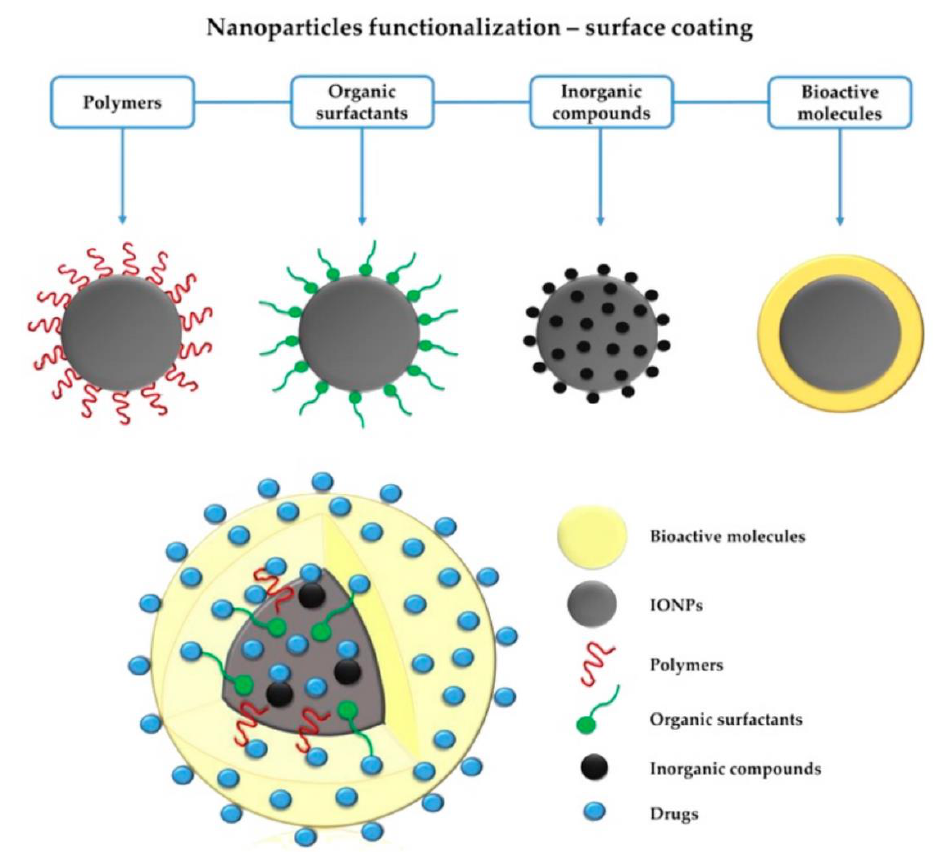
Figure 6. Schematic representation of the modification paths for the surface properties of SPIONs. (Reproduced from ref [147] published by MDPI, 2019.).